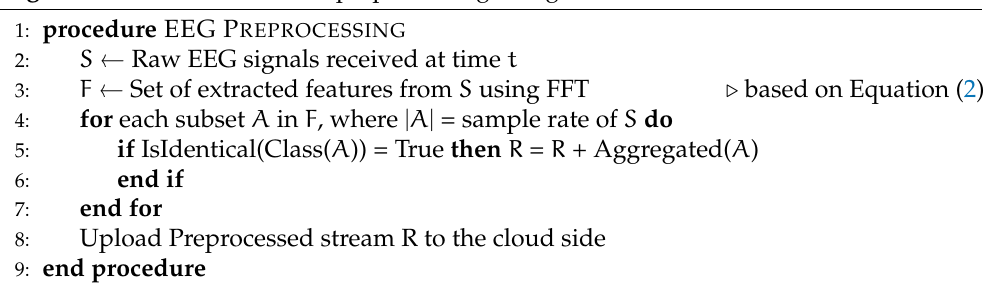
Algorithm 1 EEG Stream data preprocessing—Edge